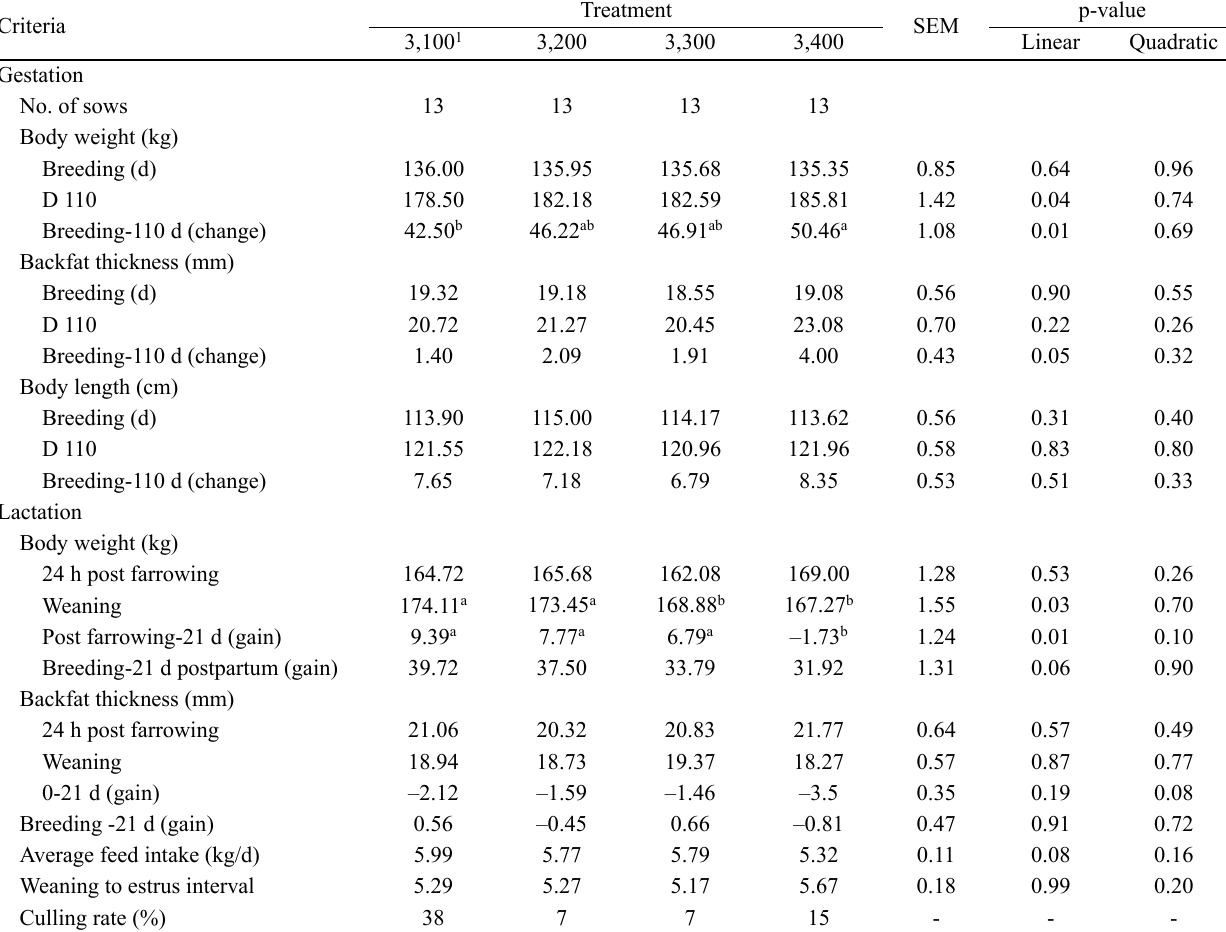
Table 2. Effects of the dietary energy levels on the body weight, back-fat, body length, feed intake and WEI of primiparous gestating and lactating